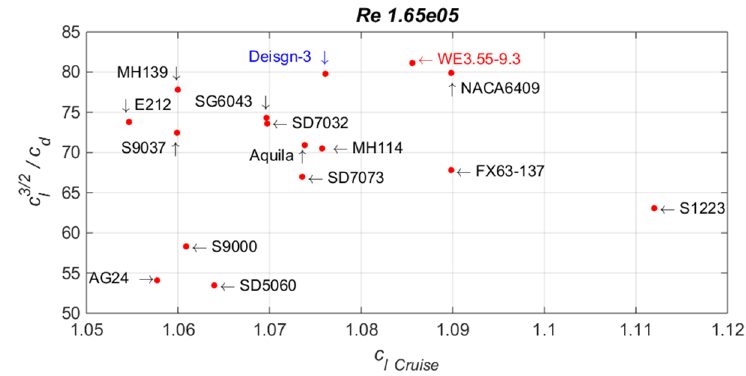
Figure 10. Performance comparison of airfoils.